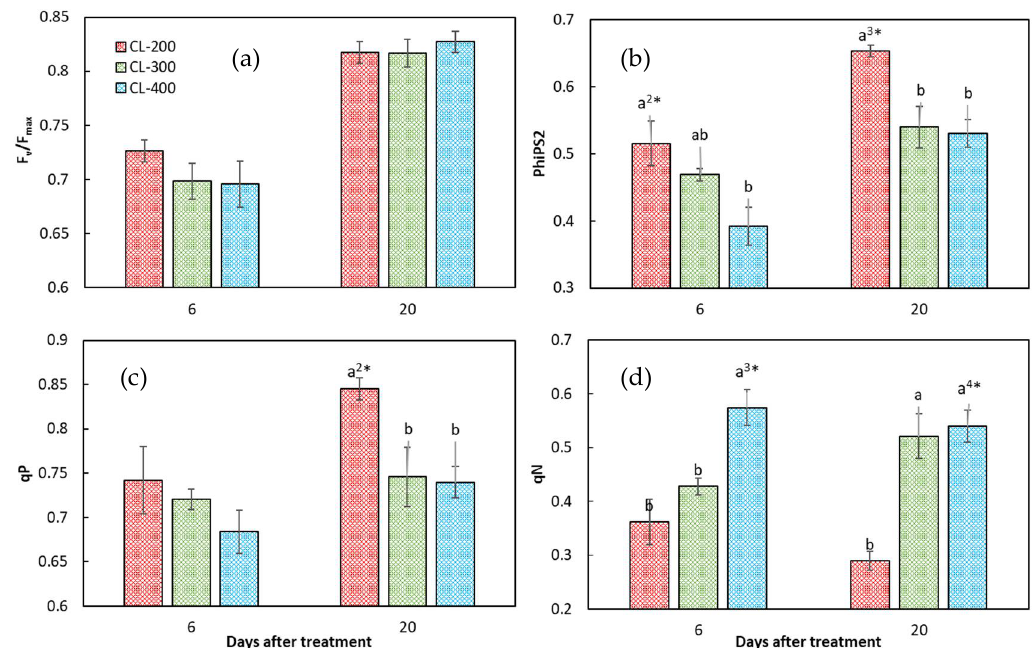
Table 3. Secondary metabolites and relative growth rate (RGR) and leaf area index (LAI) of nasturtium plants grown under continuous lighting (CL) with three different daily light integrals (DLIs) at 7, 14, and 21 days after treatment (DAT) in Experiment 2. Figure 7. The maximum quantum yield of the PSII primary photochemistry (F v /F max ) ( a ), quantum yield of the PSII electron transport (PhiPS2) ( b ), and the coefficients of photochemical quenching (qP) ( c ) and nonphotochemical quenching (qN) ( d ) of nasturtium grown under CL-200, CL-300, and CL-400 at 6 and 20 days after treatment in Experiment 2. CL-200, CL-300, and CL-400 represent the light period of 24 h per day with a light intensity at 200, 300, and 400 µmol m -2 s -1 , respectively. Values are the means ± SE ( n = 8). Different alphabet letters indicate significant differences between the treatments, the signs, 2 *, 3 *, or 4 * put after the alphabet ‘a’ at the largest mean for each parameter and each ‘days after treatment’, indicating that the probability of the ANOVA (the multiple mean comparison by Tukey) was p < 0.01, p < 0.001, or p < 1.0 × 10 −4 , respectively.